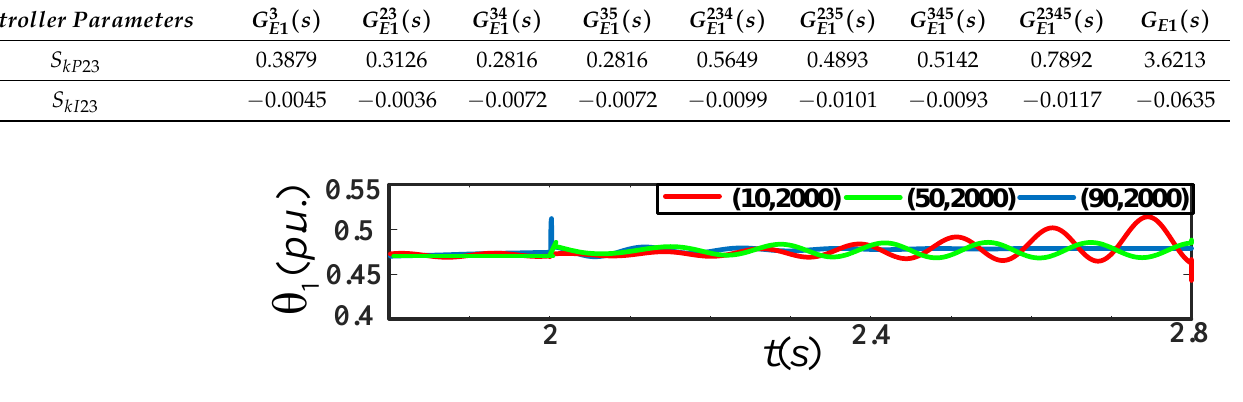
Figure 9. Time domain responses of θ of WT 1 with different control parameters of DC voltage ( k I 13 ) of WT 3. Table 4. The sensitivity of different paths of the en-stabilizing functions to the parameters of PLL.